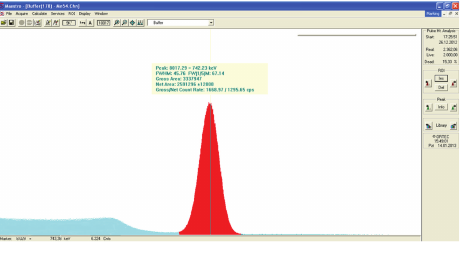
Figure 2: Gamma ray spectrum obtained from 137 Cs source. Table 1: The present activity and half-life of the radioactive sources used to obtain energies. Nuclide Activity (micro Ci)